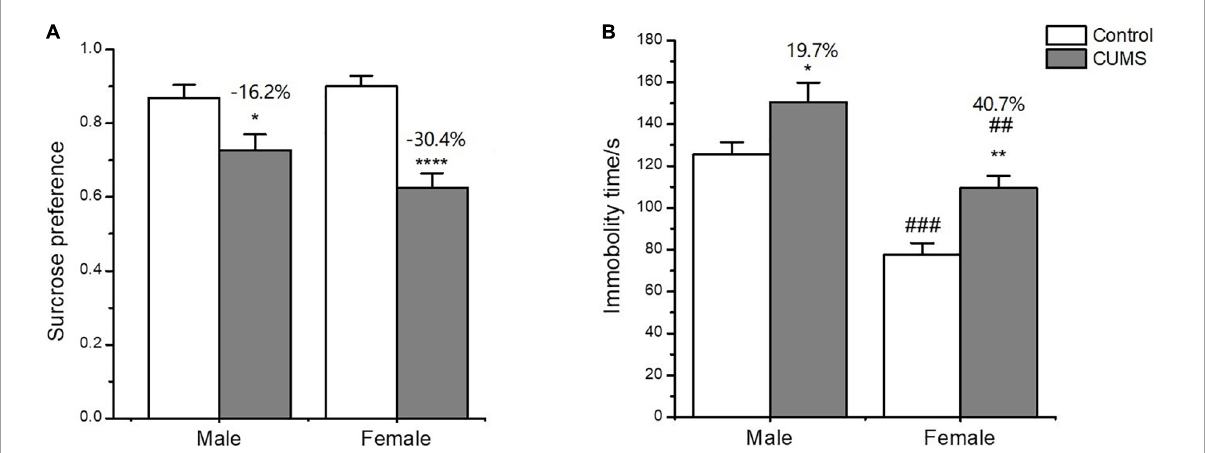
FIGURE3 Depressive-like behavior induced by CUMS in SPT and FST of male and female rats. (A) Percentage of sucrose consumption in the SPT. (B) Immobility time in the FST. * p < 0.05, ** p < 0.01, and **** p < 0.0001 vs. control with same sex, ## p < 0.01, ### p < 0.001 vs. male in same control or CUMS group.